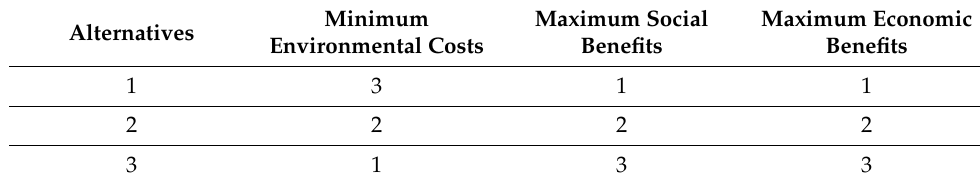
Table 9. Order of preferability for the design alternatives.